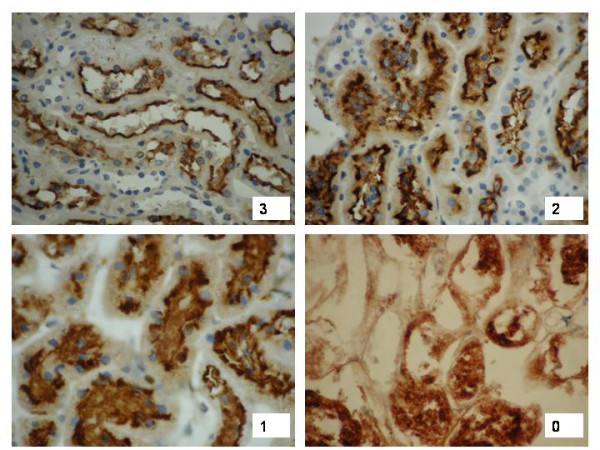
Patterns of staining of Kidney Biopsy specimens stained with CD 10 antibody. 3. Well defined, intensely stained brush border with mild or no cytoplasmic staining (immunostaining score = 3). 2. Brush border relatively well-defined, but some loss into the lumen and more cytoplasmic staining than 1. (immunostaining score = 2). 1. Loss of distinct brush border staining, staining of luminal contents and heavy cytoplasmic staining. (immunostaining score = 1). 0. Disrupted cells with diffuse staining and no definite cytoplasmic border. (immunostaining score = 0)